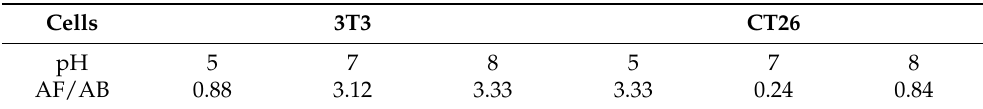
Figure 5. Deconvoluted fluorescence spectra of cells 3T3 and CT26 measured at pH 5, 7 and 8. ( a ) deconvoluted fluorescence spectra of cells 3T3 measured at pH 5, ( b ) deconvoluted fluorescence spectra of cells 3T3 measured at pH 7, ( c ) deconvoluted fluorescence spectra of cells 3T3 measured at pH 8, ( d ) deconvoluted fluorescence spectra of cells CT26 measured at pH 5, ( e ) deconvoluted fluorescence spectra of cells CT26 measured at pH 7, ( f ) deconvoluted fluorescence spectra of cells CT26 measured at pH 8. Table 3. The ratios of areas under calculated Gauss curves of free and bound NADH, AF/AB, at pH 5, 7 and 8 in deconvoluted spectra of healthy cells 3T3 and carcinoma cells CT26. Cells